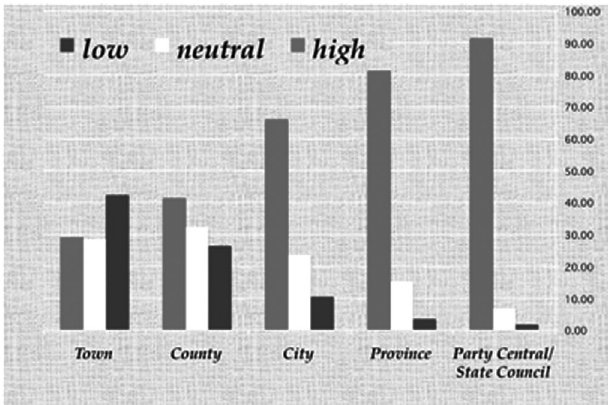
Figure 4. High levels of trust in the party